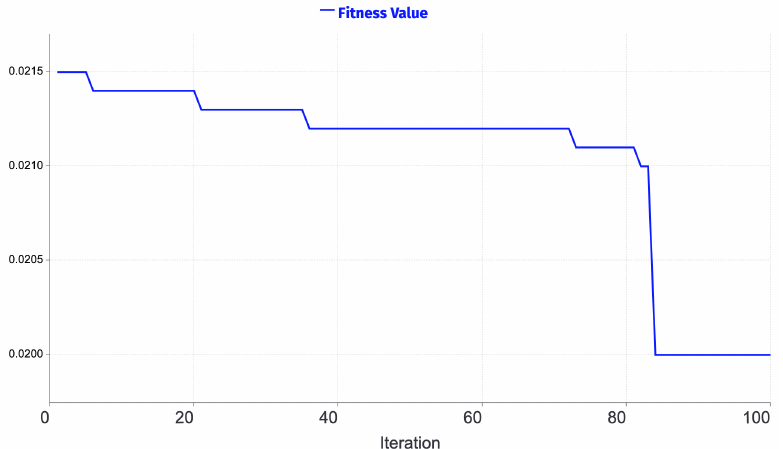
Figure A4. The training convergence curve when using the ANN with the CSO and the MSE fitness function for the dataset of Spanish companies.